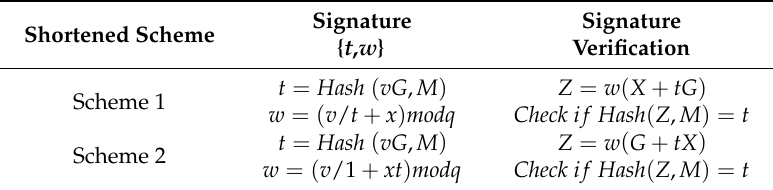
Table 1. Variants of elliptic curve digital signature